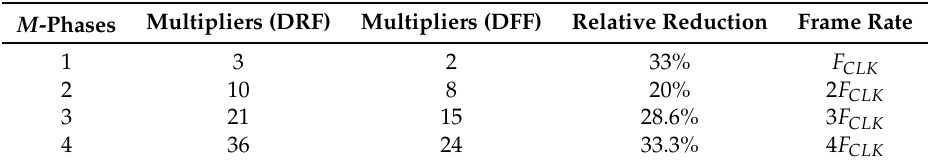
Table 1. Computational complexity of the proposed low-complexity architectures with LA optimization [33] (DRF = Direct form, DFF = Differential